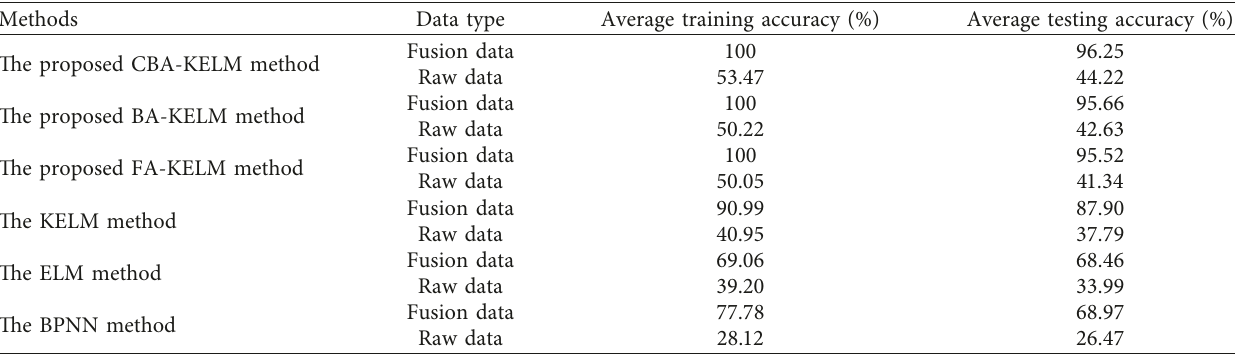
Figure 11: Fault diagnosis results: (a) CBA-KELM, (b) BA-KELM, (c) FA-KELM, (d) KELM, (e) ELM, and (f) BPNN methods with the fused dataset; (g) CBA-KELM, (h) BA-KELM, (i) FA-KELM, (j) KELM, (k) ELM, and (l) BPNN methods with the unfused dataset. Table 2: Comparisons with peer-to-peer